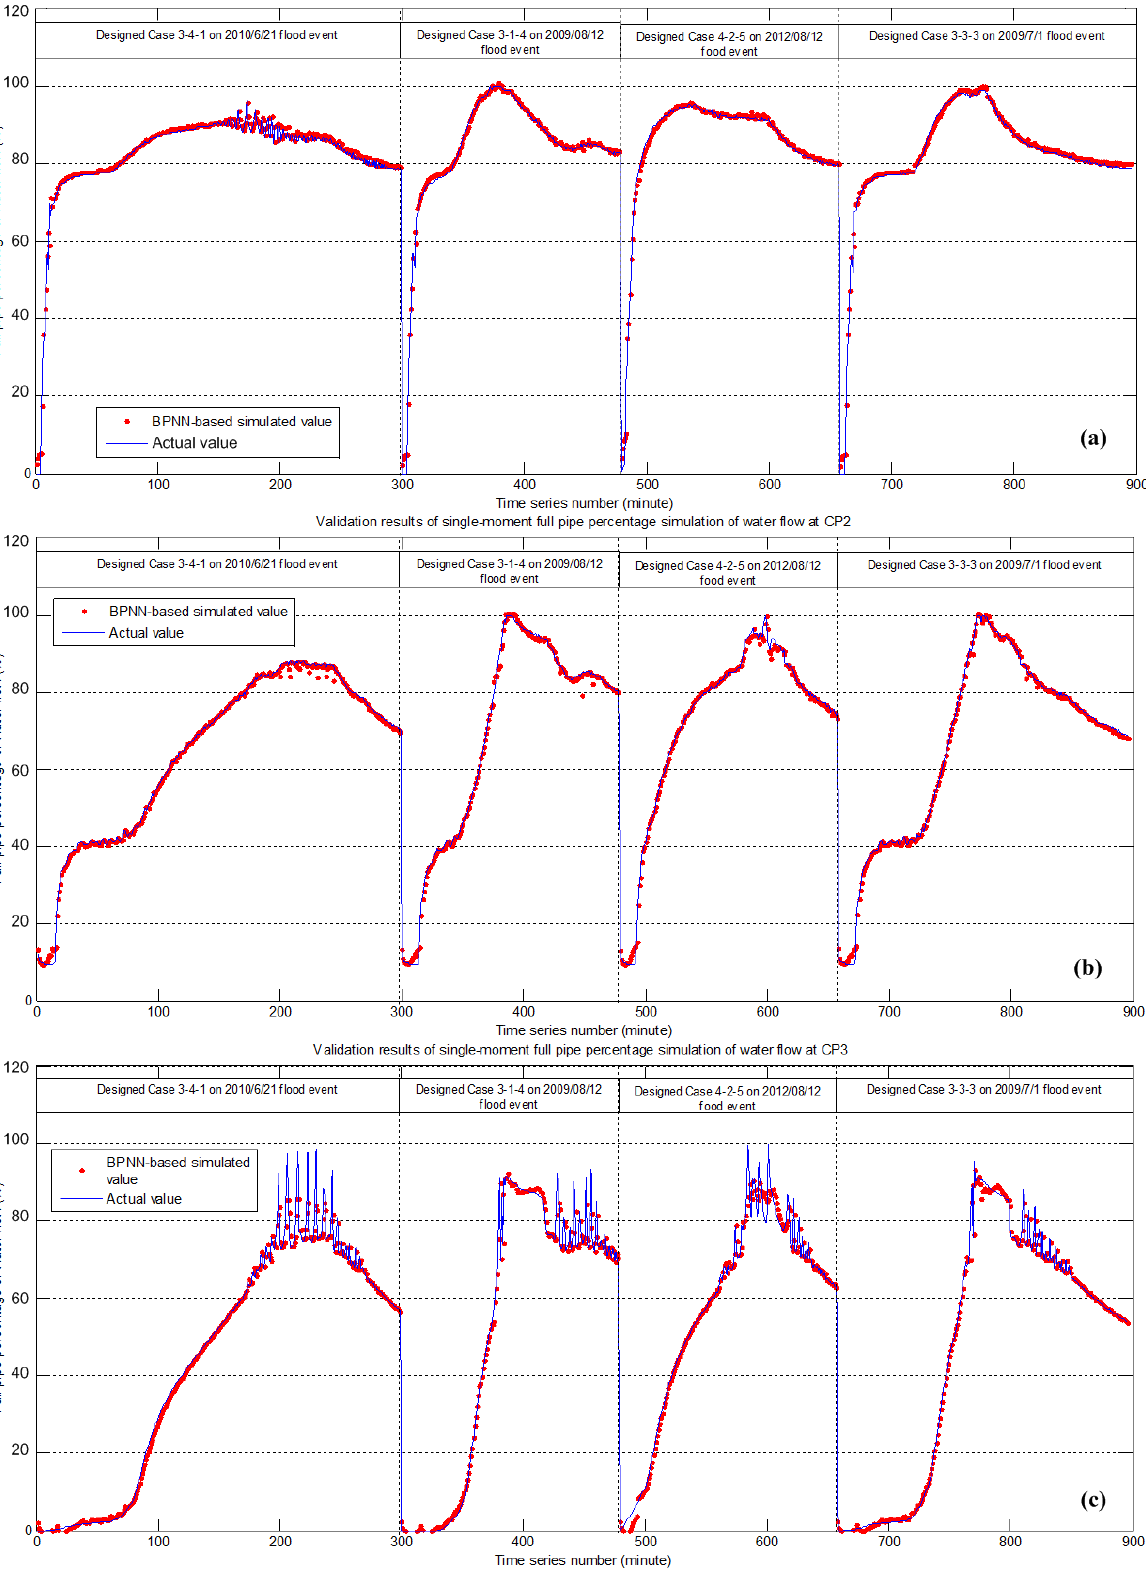
Figure 10. Validation results of single-moment full pipe percentage simulation of water flow: ( a ) at CP1; ( b ) at CP2; and ( c ) at